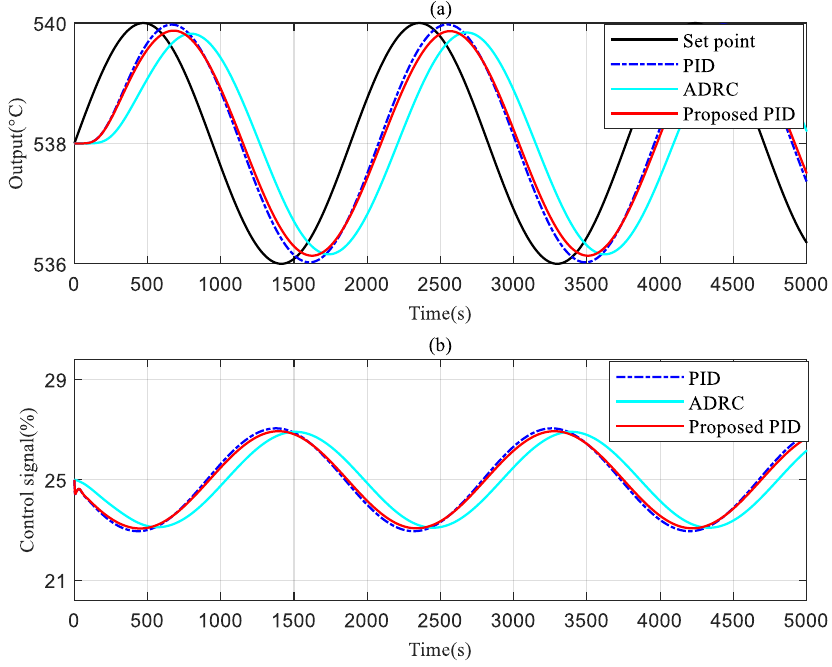
Figure 9. Set-point sinusoidal tracking performance under an operating condition of 75% load ( a ): outputs, ( b ): control signals.